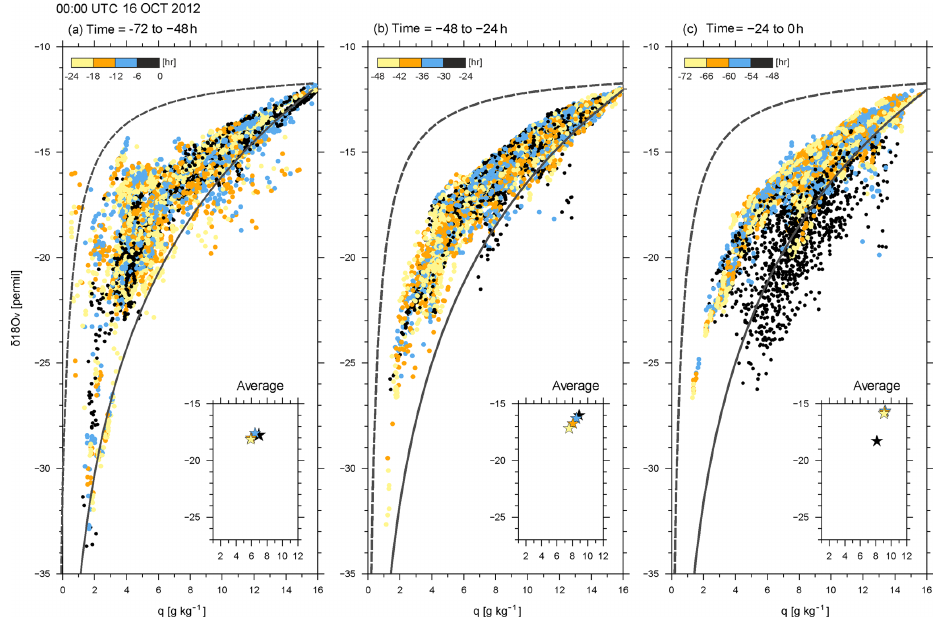
Figure 12. Scatter diagram of q and δ 18 O v along the backward trajectories of Fig. 11 during (a) the times between − 72 and − 48h, (b) times between − 48 and − 24h, and (c) times between − 24 and 0h from 00:00UTC on 16 October 2012 every 6h. The colour of dots changes every 6h. The mixing and Rayleigh lines are indicated by dashed and solid lines, respectively. The averaged q and δ 18 O v every 6h are displayed in the bottom right corner of each